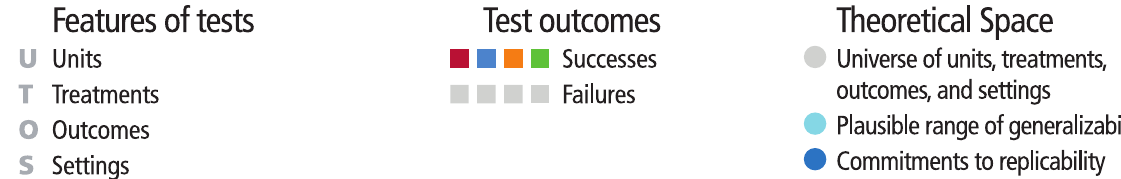
Fig 1. There is a universe of distinct units, treatments, outcomes, and settings and only a subset of those qualify as replications—a study for which any outcome would be considered diagnostic evidence about a prior claim. For underspecified theories, there is a larger space for which the claim may or may not be supported—the theory does not provide clear expectations. These are generalizability tests. Testing replicability is a subset of testing generalizability. As theory specification improves (moving from left panel to right panel), usually interactively with repeated testing, the generalizability and replicability space converge. Failures-to-replicate or generalize shrink the space (dotted circle shows original plausible space). Successful replications and generalizations expand the replicability space—i.e., broadening and strengthening commitments to replicability across units, treatments, outcomes, and